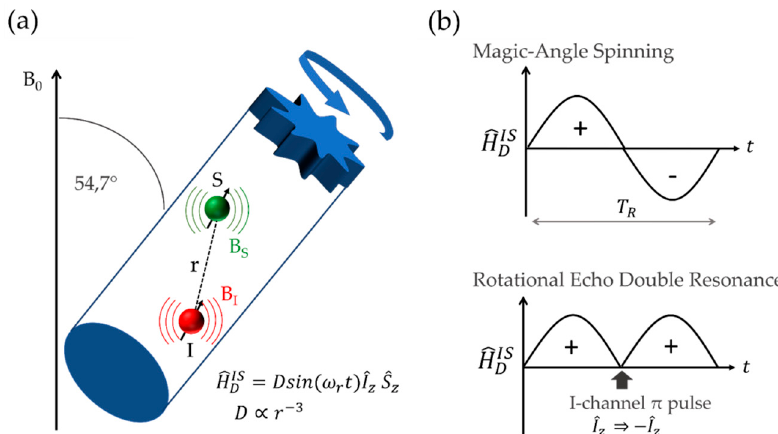
Figure 10. Principle of the rotational echo double resonance (REDOR) experiment. ( a ) Schematic representation of the dipolar interaction of two spins I and S inside a spinning rotor inclined at the magic angle. Local magnetic fields produced by their magnetic moments ( B I and B S ) modify the precession frequency of the interacting nuclei. ( b ) Under MAS conditions, the heteronuclear dipolar Hamiltonian ˆ H IS oscillates sinusoidally with rotor orientation, leading to cancellation upon completion of the rotor cycle in the fast spinning limit. Sign inversion created by a π -pulse applied to the non-observed I spins (turning Î z into − Î z ) interferes with this cancellation (bottom), resulting in the dipolar re-coupling effect.